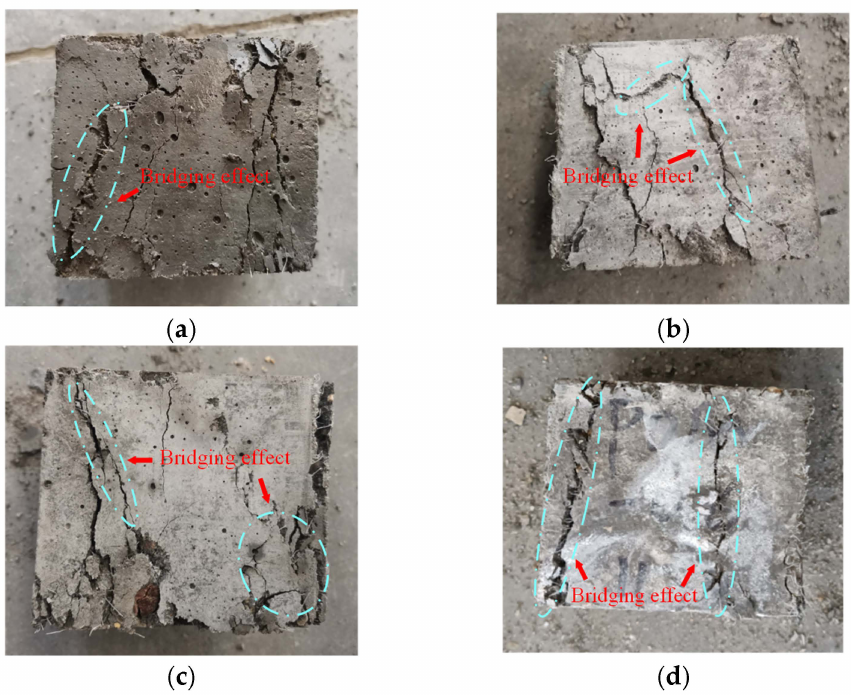
Figure 8. Failure performance of POM0.6 specimens with different ages after cube compressive test: ( a ) 3 d; ( b ) 7 d; ( c ) 14 d; and ( d ) 28